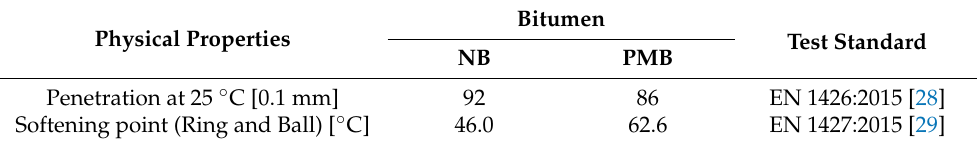
Table 1. Physical properties of neat bitumen and PMB. Physical